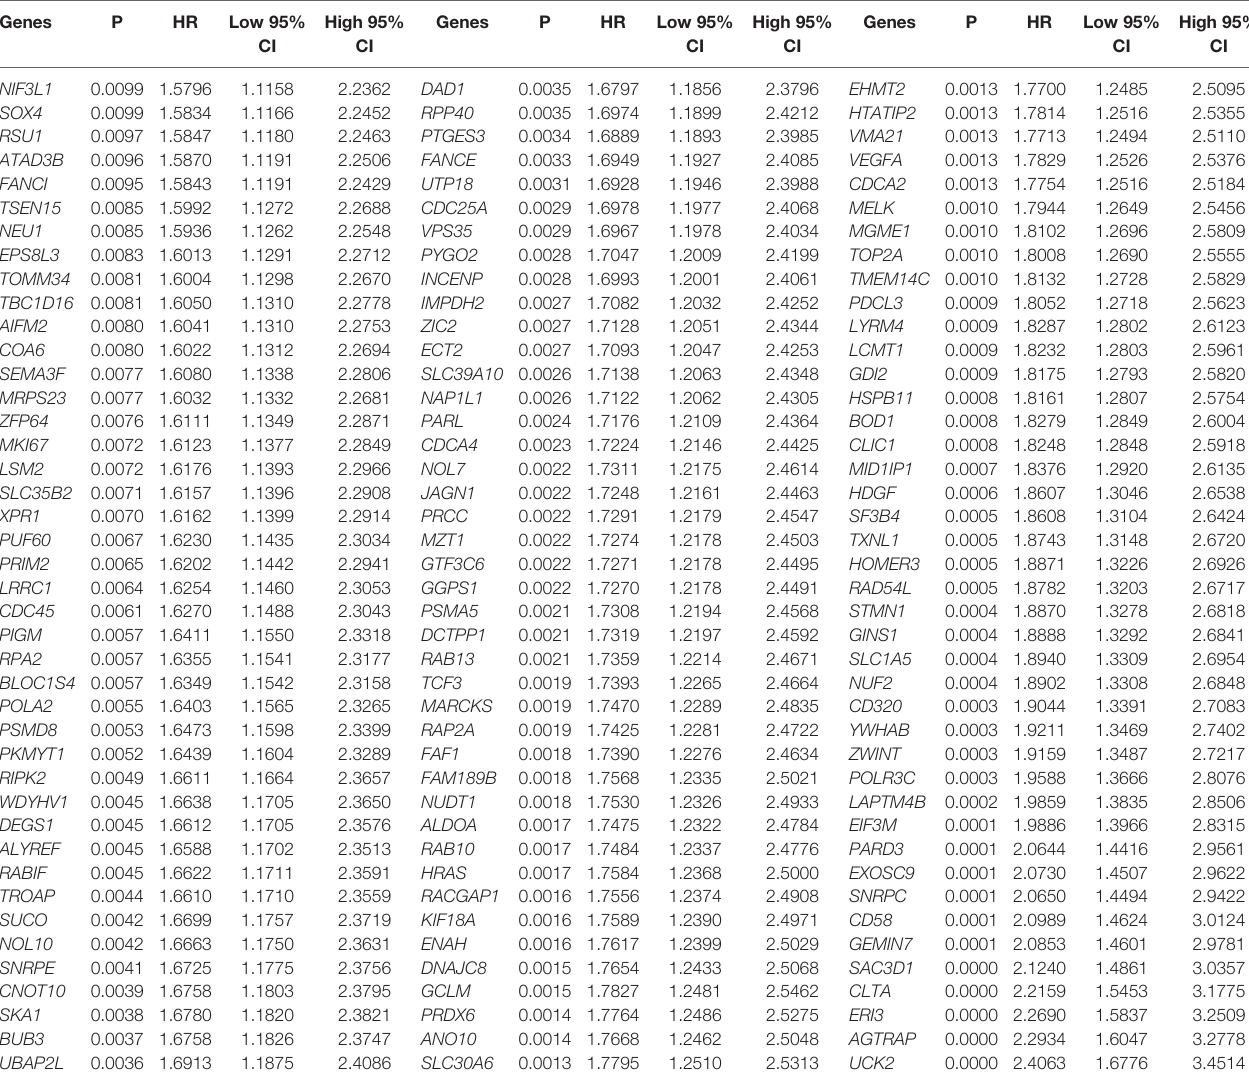
TABLE 1 | 126 differential expressed genes about overall survival using Kaplan-Meier. Genes